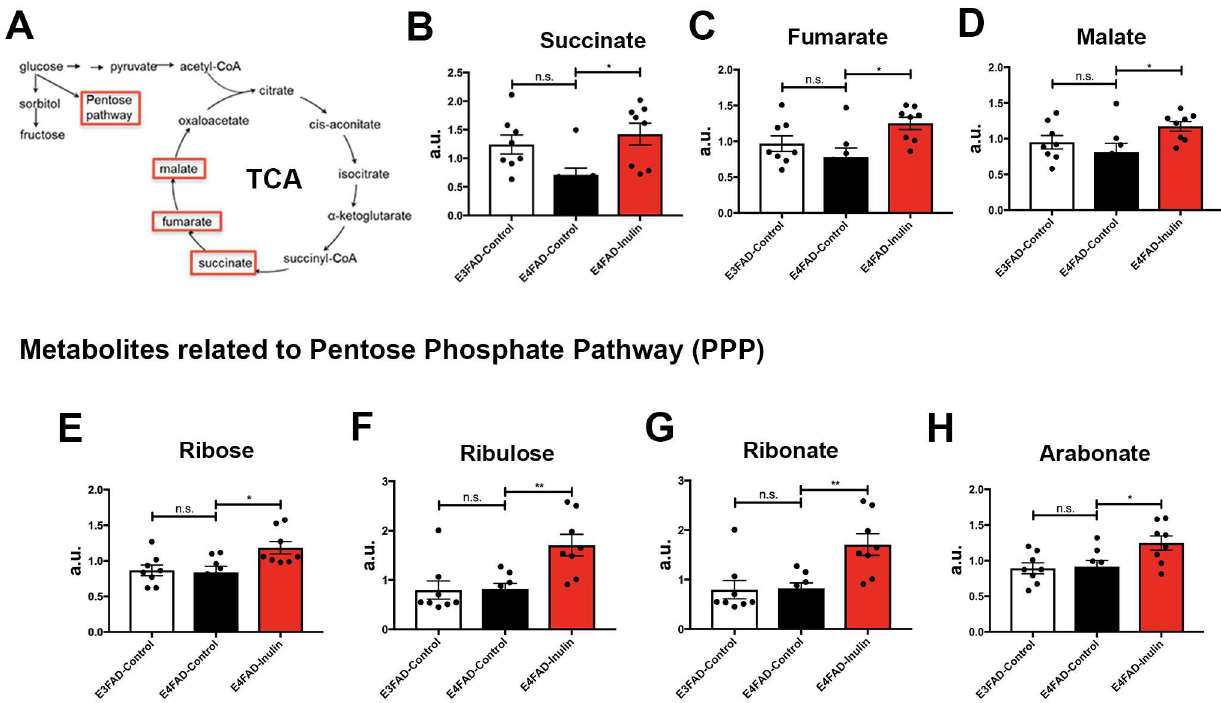
Fig 5. Analysis of inulin-induced changes in glycolytic metabolism in the periphery. (A) An illustration of the glycolytic pathway through the TCA cycle and PPP. E4 FAD mice fed prebiotic inulin showed changes in the levels of TCA cycle metabolites, including (B) succinate, (C) fumarate, and (D) malate, compared to E4 FAD mice fed the control diet. E4 FAD mice fed the prebiotic inulin showed a significant increase in the levels PPP-associated metabolites including (E) ribose, (F) ribulose, (G) ribonate, and (H) arabonate compared to E4 FAD mice fed the control diet. n.s. = not significant; � p < 0.05; �� p <